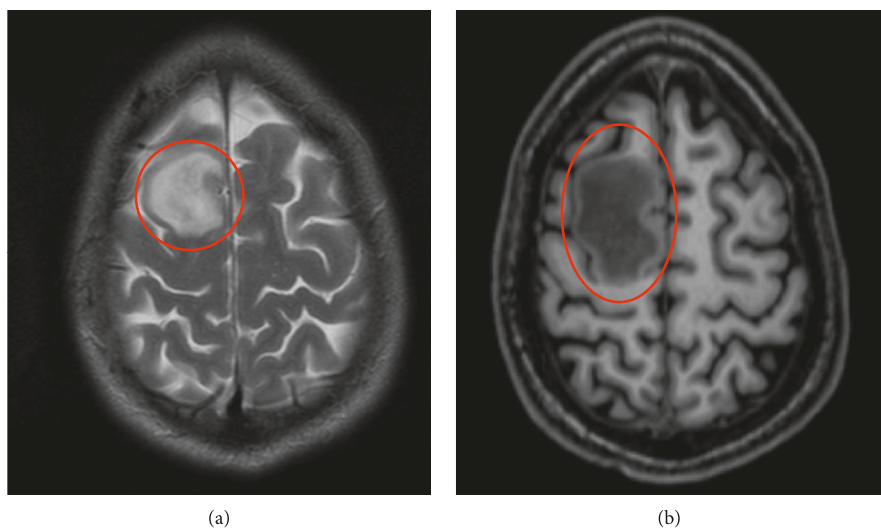
Figure 2: Cranial MRI in T2 and T1, respectively—frontal lesion corresponding to